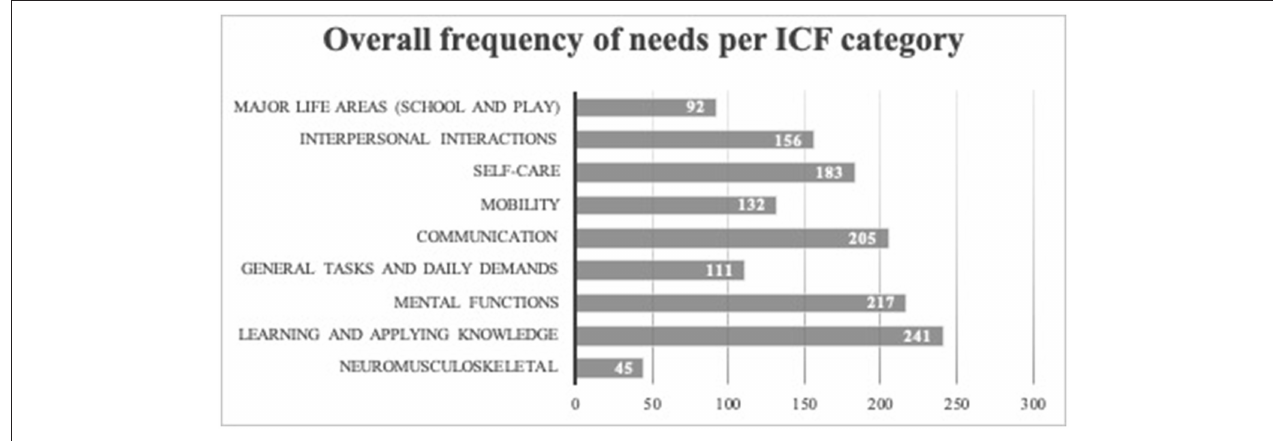
FIGURE 1 | Frequency of needs reported in the EHC plans per category of need.